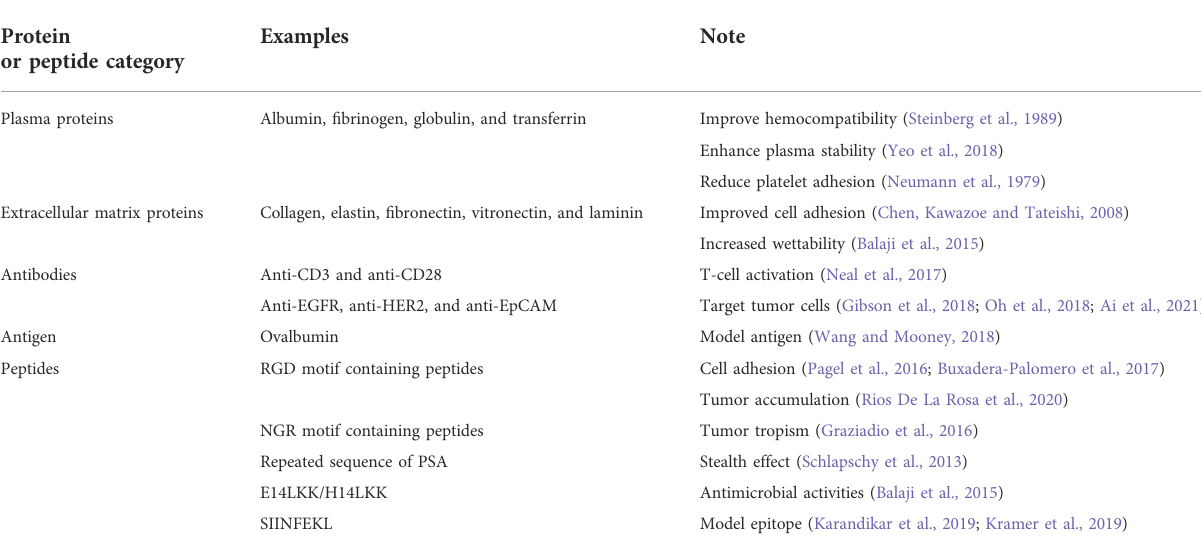
TABLE 5 Some common proteins and peptides of surface modi fi cation of biomaterials. Protein or peptide